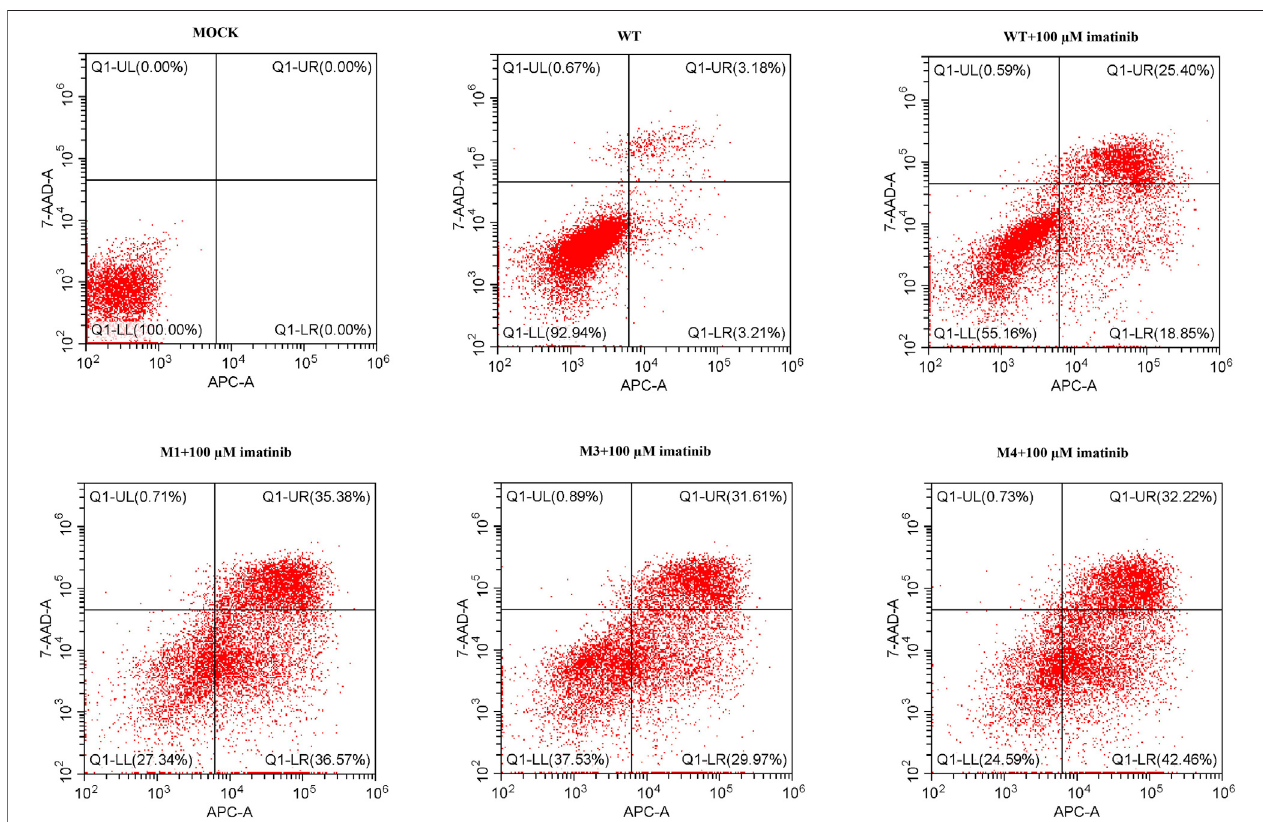
FIGURE 7 | Cell apoptotic rate was assessed by fl ow cytometry analysis in cells transfected with wild-type or mutated (M1, M3, or M4) c-KIT genes after imatinib treatment. Q1-LL indicates the live cells, Q1-LR early apoptotic cells, Q1-UR late apoptotic cells, and Q1-UL dead cells. The data showed that the late apoptotic rate of M3- or M4-mutated cells was lower than that of M1-mutated cells when they were treated with 100 μ M imatinib.